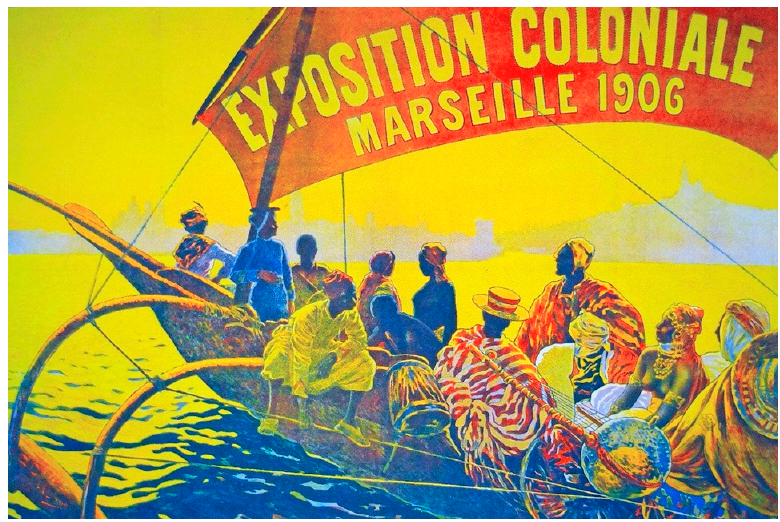
Figure 19. A poster for the Exposition Coloniale in Marseille in 1906 by David Delpianne, courtesy of the Regis family.